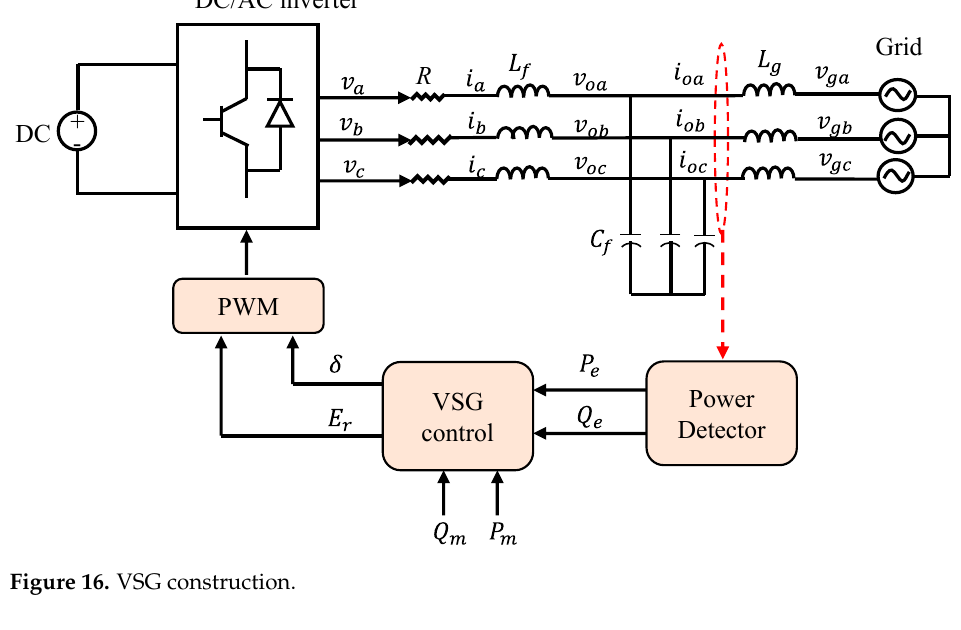
Figure 16. VSG construction.